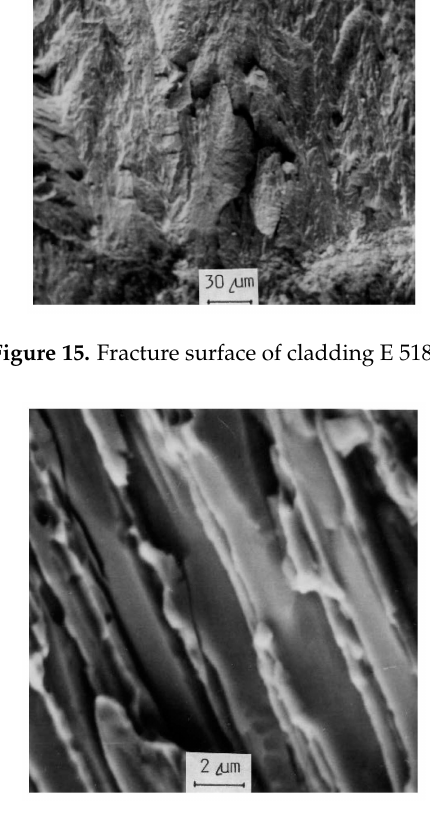
Figure 16. Detail of decohesive